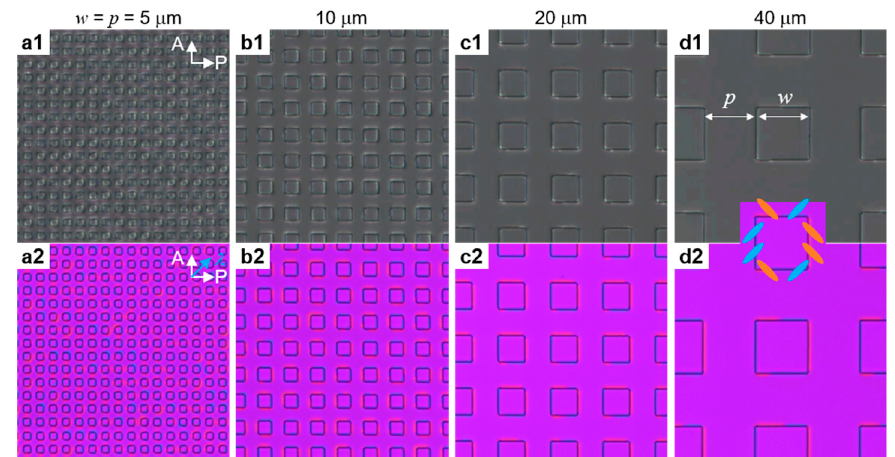
Figure 4. The array of square-shaped pillars with pillar width w and pillar spacing p observed by polarizing optical microscopy (POM): ( a ) w = p = 5 μ m; ( b ) w = p = 10 μ m; (c) w = p = 20 μ m; and ( d ) w = p = 40 μ m. POM images: ( a1–d1 ) under crossed polarizers with brightness adjusted for visibility; and ( a2–d2 ) under crossed polarizers with a full-wave plate. Pillar height is h = 2 μ m and cell thickness is 5.6 μ m. P, polarizer; A, analyzer; λ , full-wave plate. The schematic in (d2) represents LC director near a pillar.